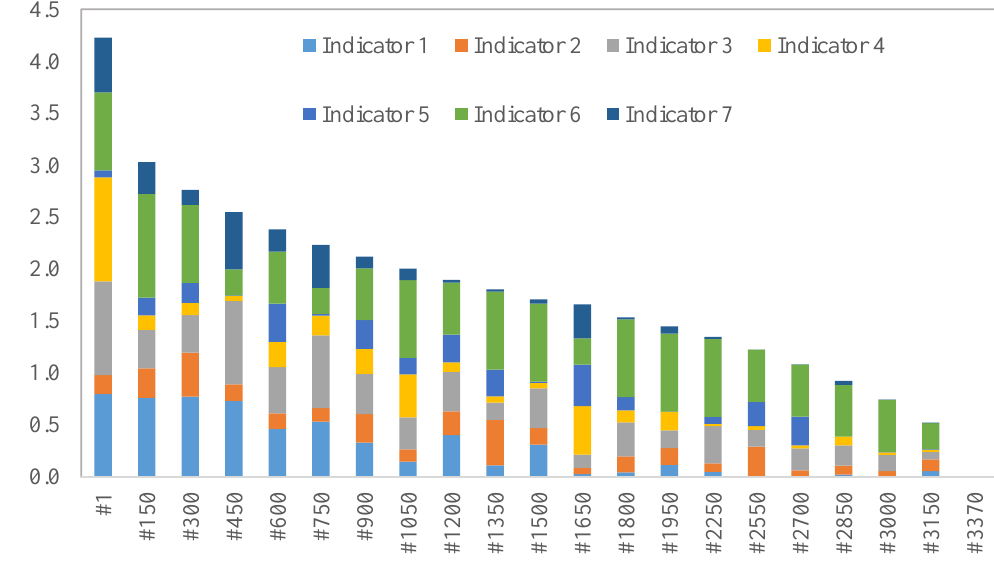
Figure 4. WSM_EW rankings (score/ranking).